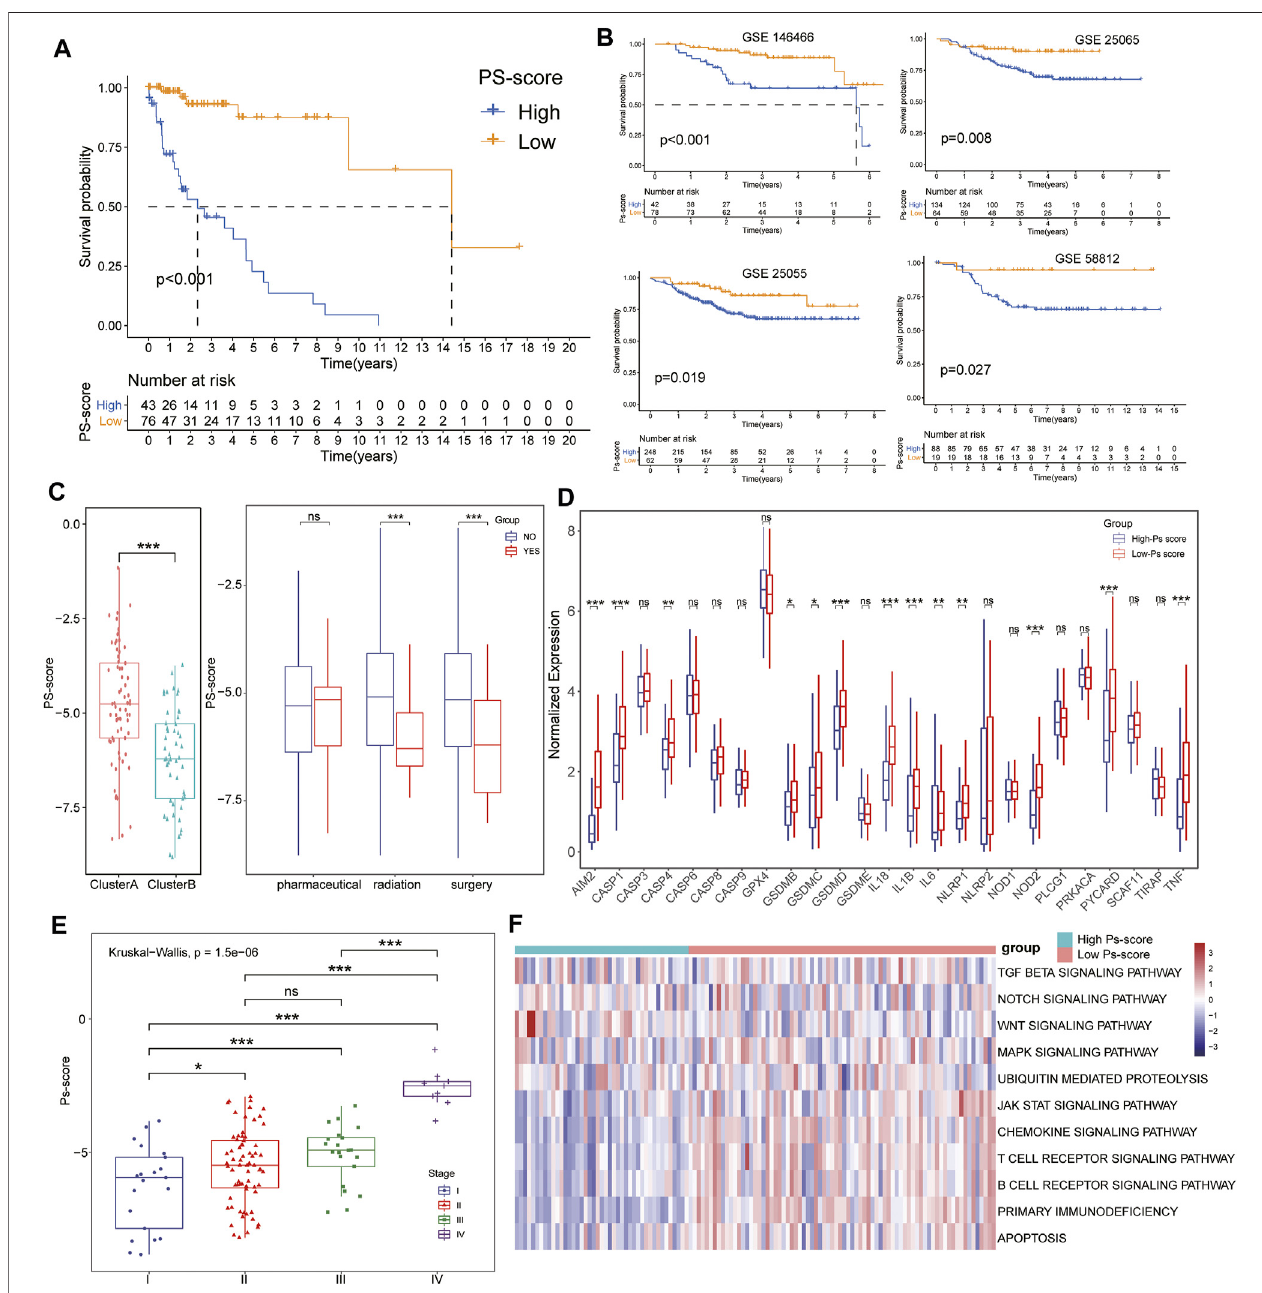
FIGURE4| CharacteristicsofPs-scoresandcorrelationtopyroptosisinTNBC. (A – B) Kaplan – Meiercurvesofoverallsurvival(OS)forthepatientswithTNBCinthe high- and low-Ps-score groups in the TCGA (A) or GEO data sets (B) . (C, E) The box plots show that ClusterB possessed a lower level of Ps-scores associated with pharmaceuticalandsurgicaltherapies,andlowerpathologicalstages. (D) Boxdiagramdisplayingtheexpressionofpyroptosis-related signaturessigni fi cantlyincreased in the low Ps-score groups. (F) Heatmap used to visualize pathways analyzed by GSVA showing the active biological pathways in distinct pyroptosis-related